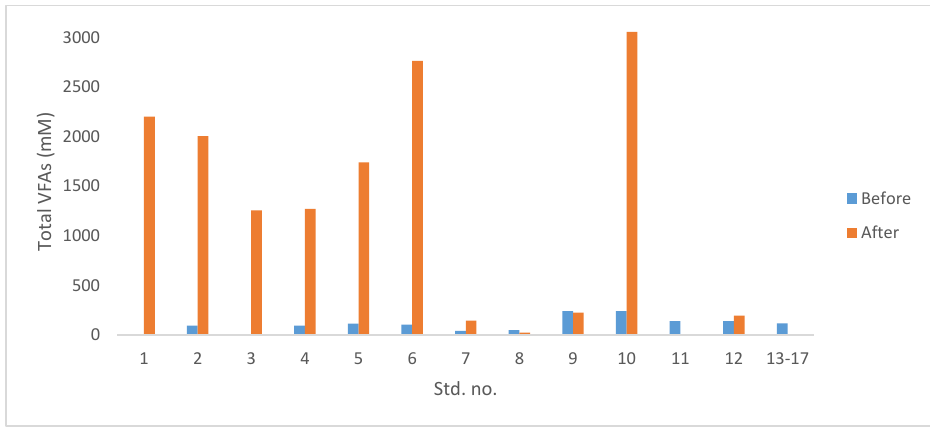
Figure 5. Total VFAs before and after AD of pot ale spent grain